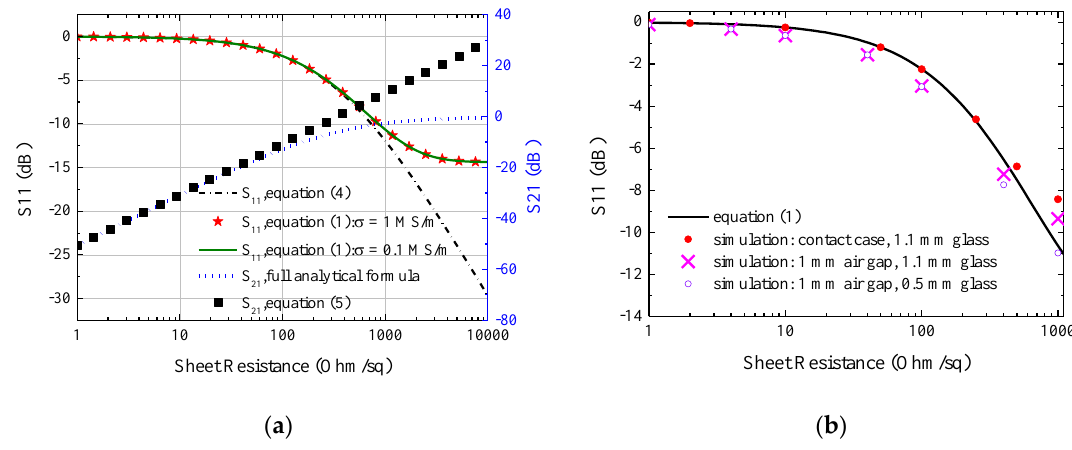
Figure 3. ( a ) Analytical calculations for ideal case; ( b ) simulations for nonideal cases. Default conductivity for nanofilm is 1 MS/m, glass thickness is 1.1 mm, and working frequency is 2.5 GHz.